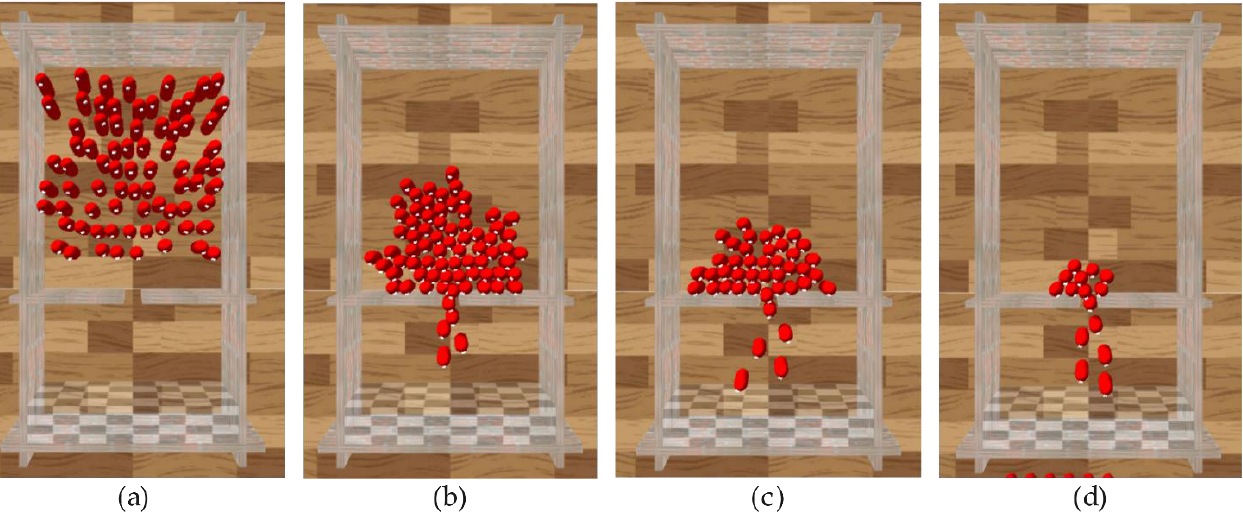
Figure 6. A temporal sequence of an experimental result in scenario I. ( a – d ) Stills of the experi- mental result. The temporal sequence of these stills is sorted